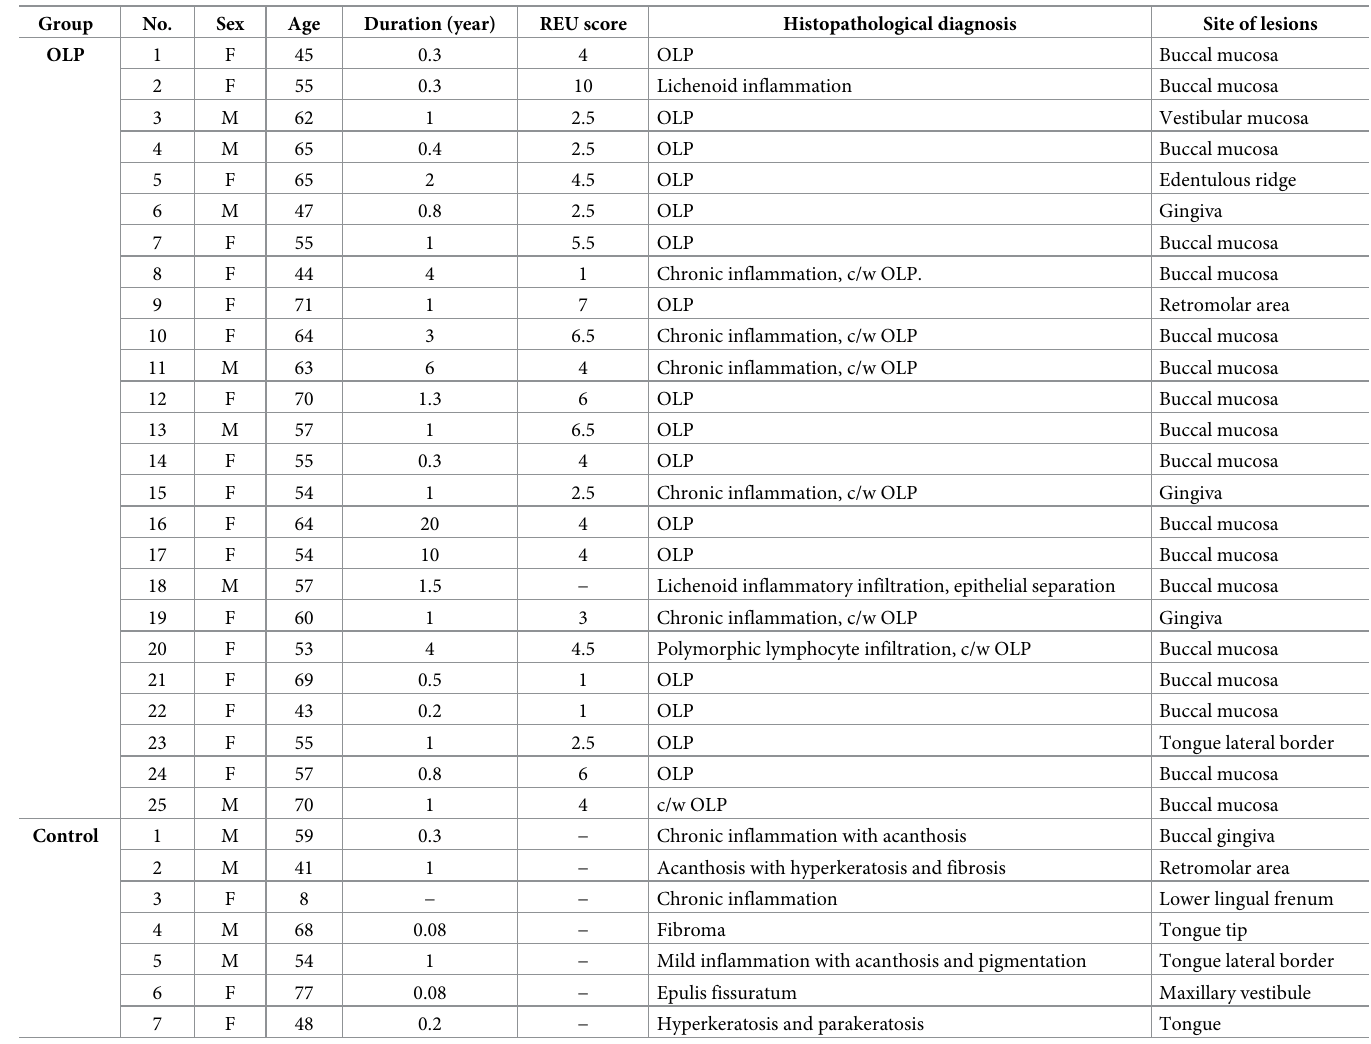
Table 2. Clinicopathological characteristics of OLP and control